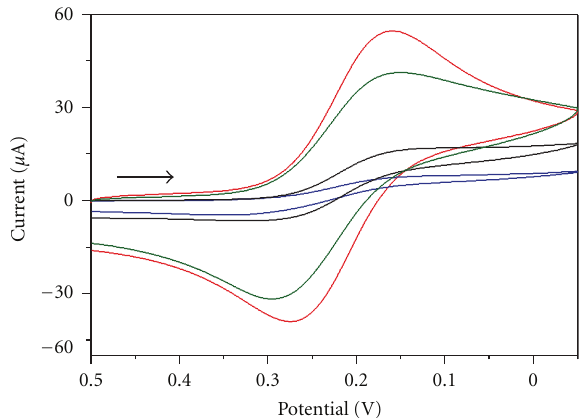
Figure 8: CVs of potassium ferricyanide (1mM) in 0.1M KCl at 0.1V/s. Red: bare gold, blue: silica film/sphere-coated electrode, black: silica film after sphere removal via soaking in chloroform for 3 hrs, and green: silica film after gold particle growth for 45